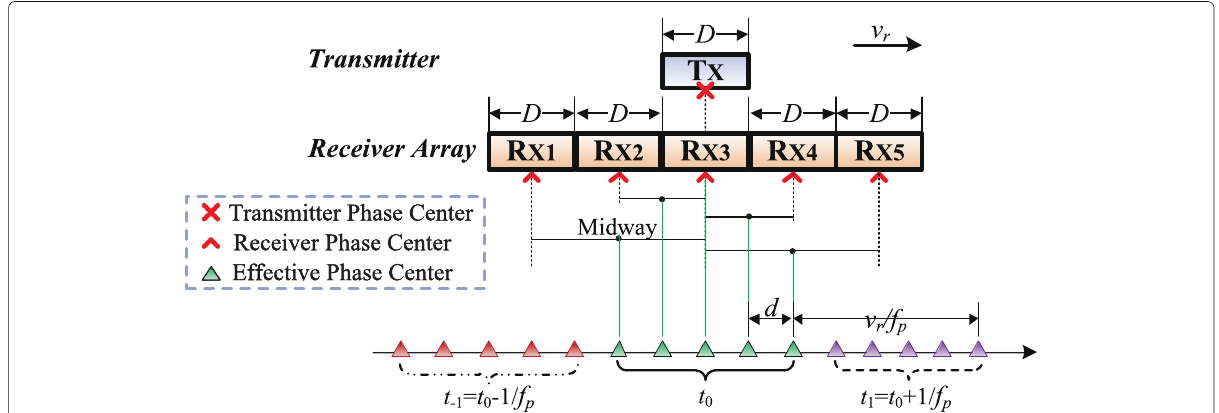
Fig. 1 Illustration of multichannel SAR. The positions of transmitter (Tx) and receivers (Rx), and corresponding positions of EPCs in azimuth multichannel SAR system. Note that D = 2